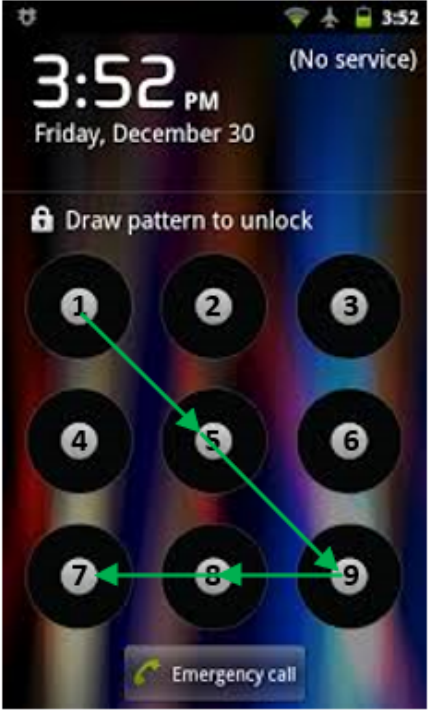
Figure 1. The 3 × 3 pattern unlock grid and a pattern 1 → 5 → 9 → 8 →